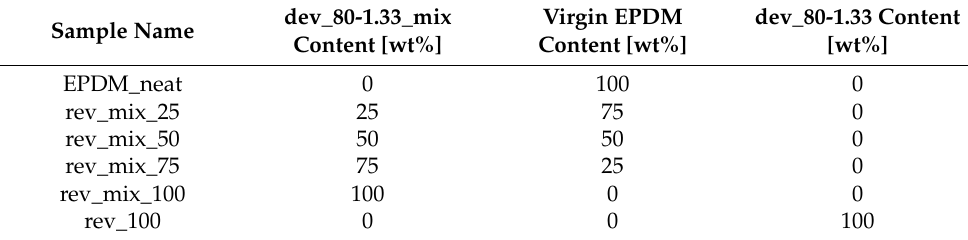
Table 4. Composition and nomenclature of EPDM